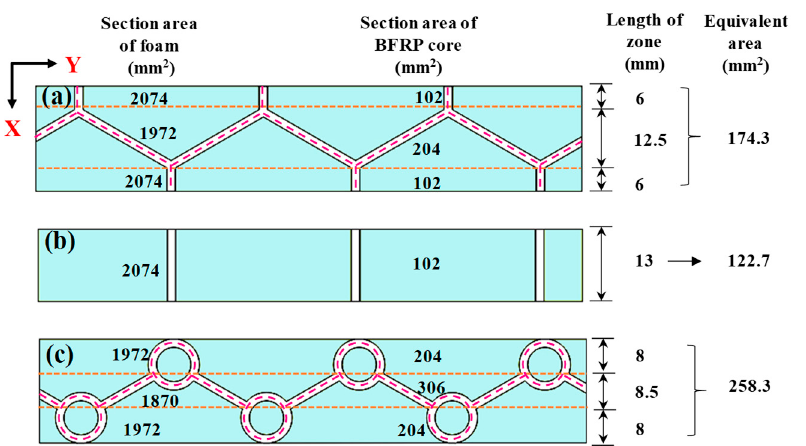
Figure 9. Diagram of the analysis of the equivalent cross-sectional area of the trabeculae and honeycomb wall of the HP fc and EBEP fc : ( a ) trabeculae area of the HP fc ; ( b ) honeycomb wall area of the HP fc and EBEP fc ; and ( c ) trabeculae area of the EBEP fc . The data in the first and second columns from the left in the figure are the cross-sectional areas of each foam and BFRP core skeleton, respectively.